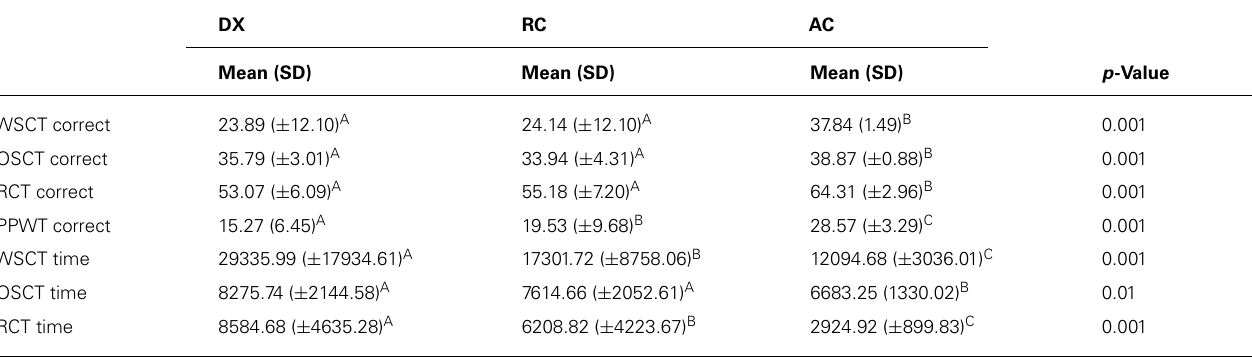
Table 1 | Mean correct responses and mean completion time per BALE task, for each of the three